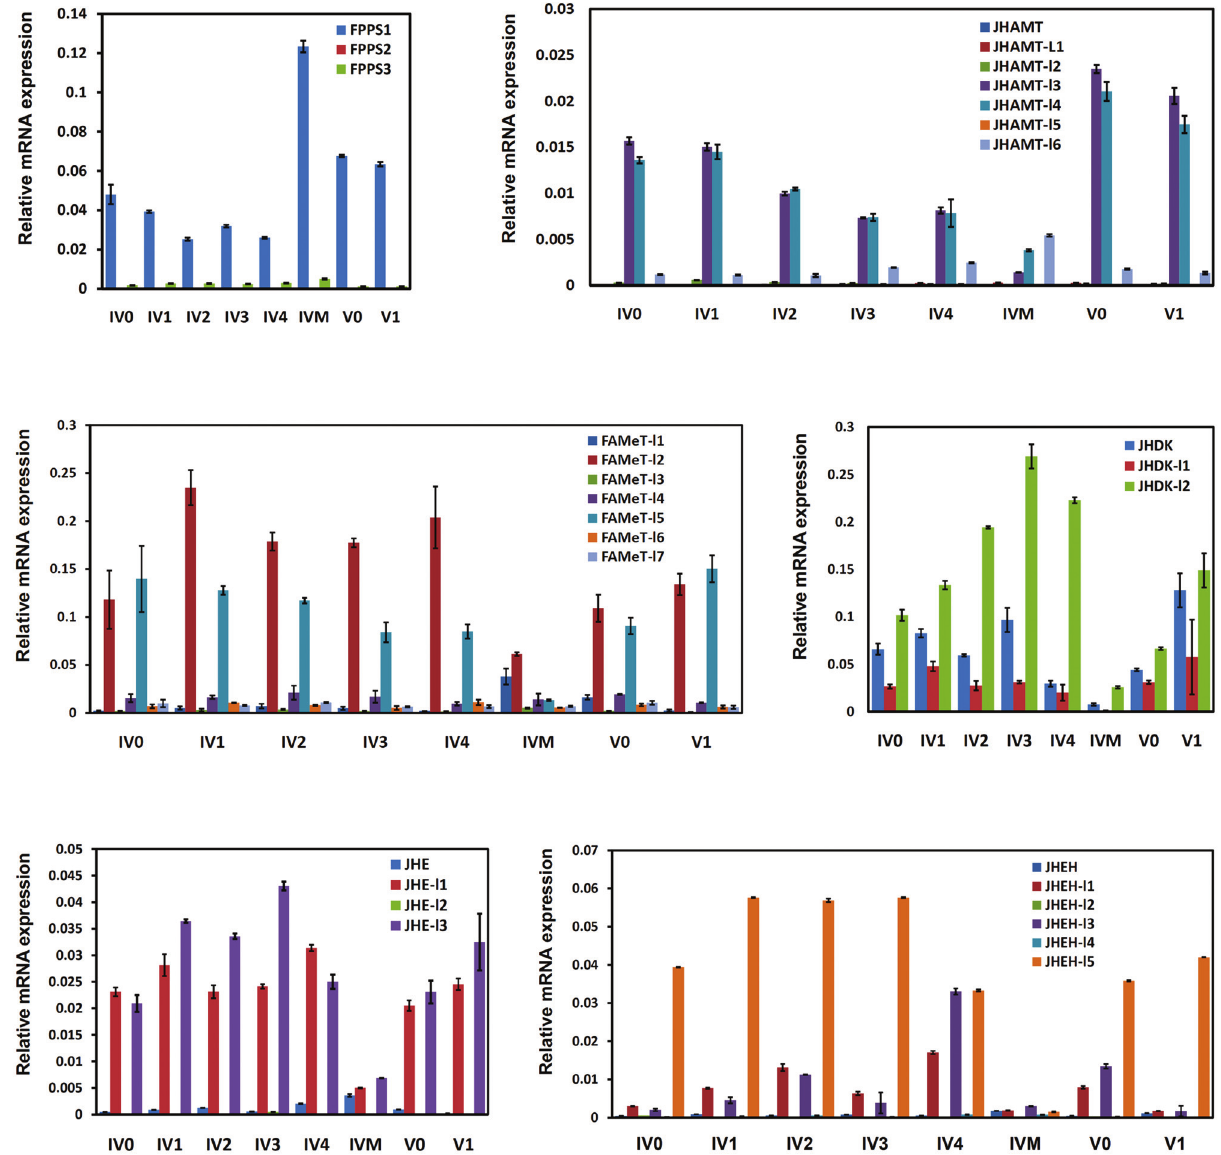
Figure 6 - Expression patterns of JH-related genes with multiple copies during larval growth and molting in B. mori . Quantitative analysis of the gene ex- pression of JH-related genes with multiple copies during larval growth and molting in B. mori was performed by real-time RT-PCR. The B. mori ribo- somal protein L3 ( RpL3 ) gene was used as an internal control. IV0, immediately after completion of the third larval molting and the beginning of feeding in the fourth larval instar; IV1, one day after feeding in the fourth larval instar; IV2, two days after feeding in the fourth larval instar; IV3, three days after feedinginthefourthlarvalinstar;IV4,fourdaysafterfeedinginthefourthlarvalinstar;IVM,thefourthlarvalmolting;V0,immediatelyaftercompletion of the fourth larval molting and the beginning of feeding in the fifth larval instar; V1, one day after feeding in the fifth larval